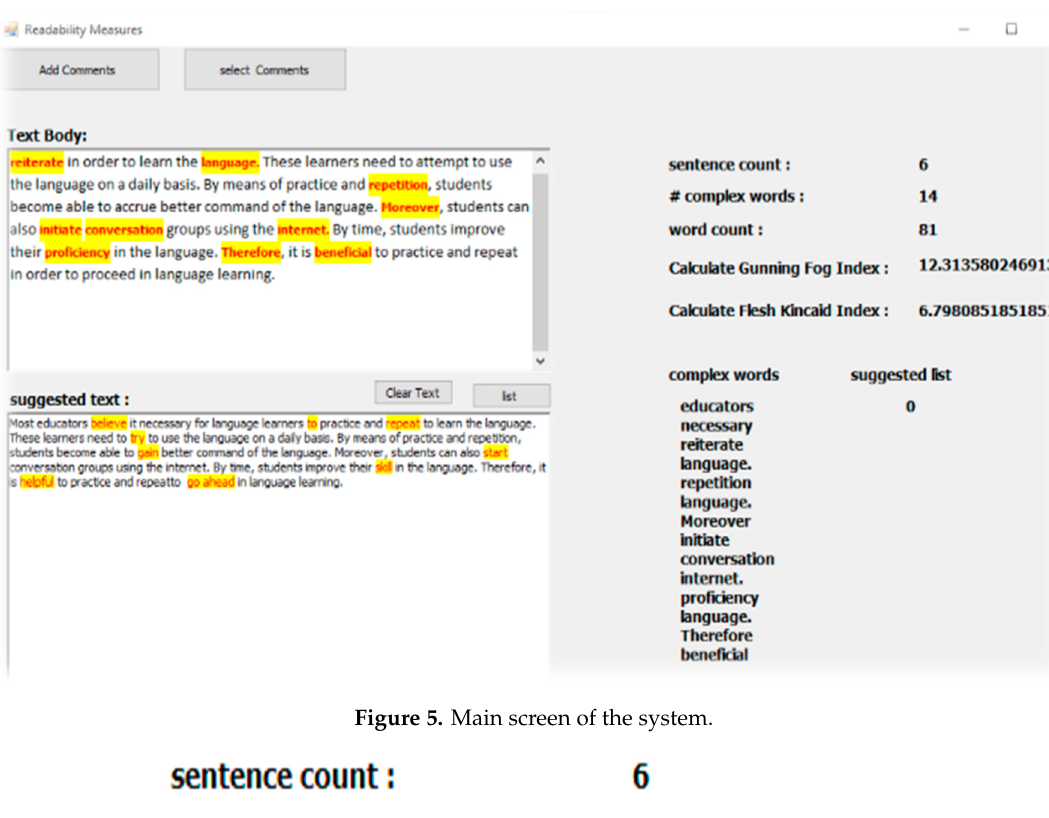
Figure 5. Main screen of the system.